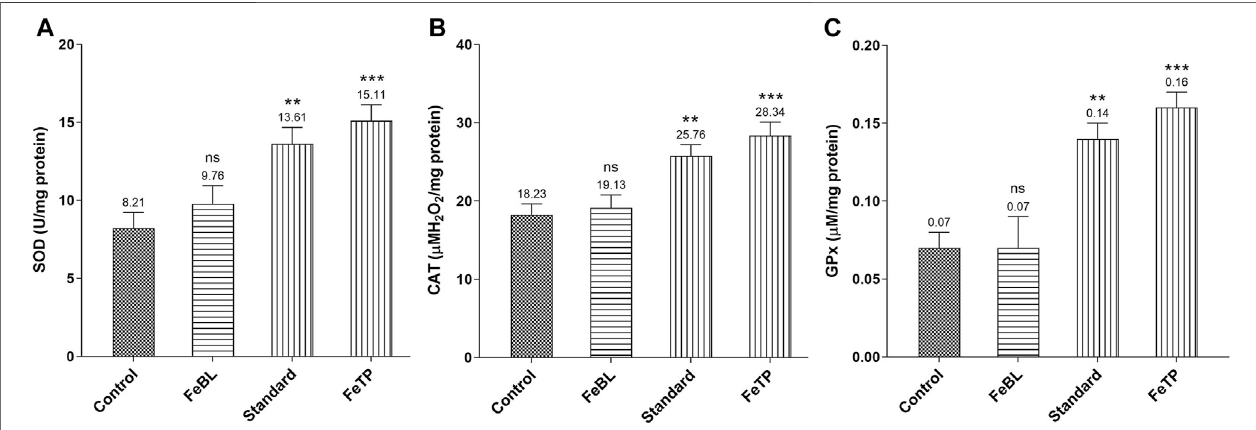
FIGURE 5 | Effect of FeTP on antioxidant enzyme pro fi le in granulation tissue by estimation of (A) SOD level, (B) CAT level, and (C) GPx level. Data represented as mean ± SEM, analyzed by one-way ANOVA followed by Dunnett ’ s test. Mean values are shown above bar and error bar. Signi fi cant difference ** p < 0.01, *** p < 0.001, and ns: non-signi fi cant in comparison to control